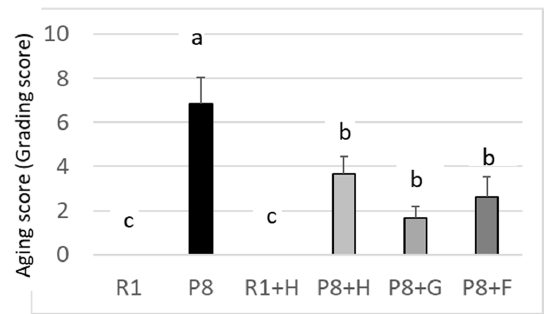
Figure 2. Effects of dietary peanut, germ-rich fraction, and ferulic acid on the aging score of SAMR1 and SAMP8 . Aging score was tentatively calculated from the degree of disappearance of the glossiness of the back coat and the degree of lordokyphosis of the spine appearance. Five grades (1–5: from weaker to stronger) were used depending on the severity of appearance. R1: senescence- accelerated resistant mice (SAM-R1) group fed with basal diet; P8: senescence-accelerated mouse prone/8 (SAMP8) group fed with basal diet; R1 + H: SAM-R1 group fed with basal diet with added peanut wholegrain; P8 + H: SAMP8 group fed with basal diet with added peanut wholegrains; P8 + G: SAMP8 group fed with basal diet with added germ-rich fraction of wholegrain; P8 + F: SAMP8 group fed with basal diet with added ferulic acid. Groups without a common letter differ significantly ( p < 0.05).